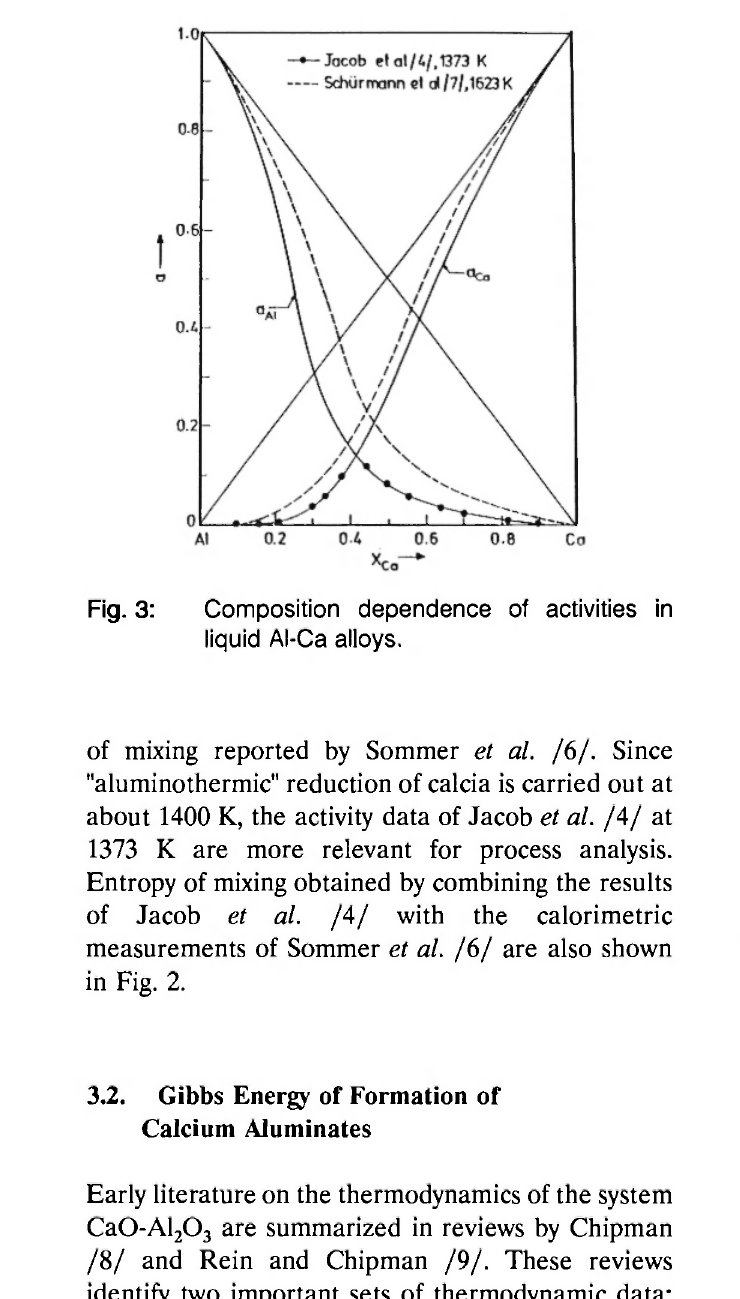
Fig. 3: Composition dependence of activities in liquid Al-Ca